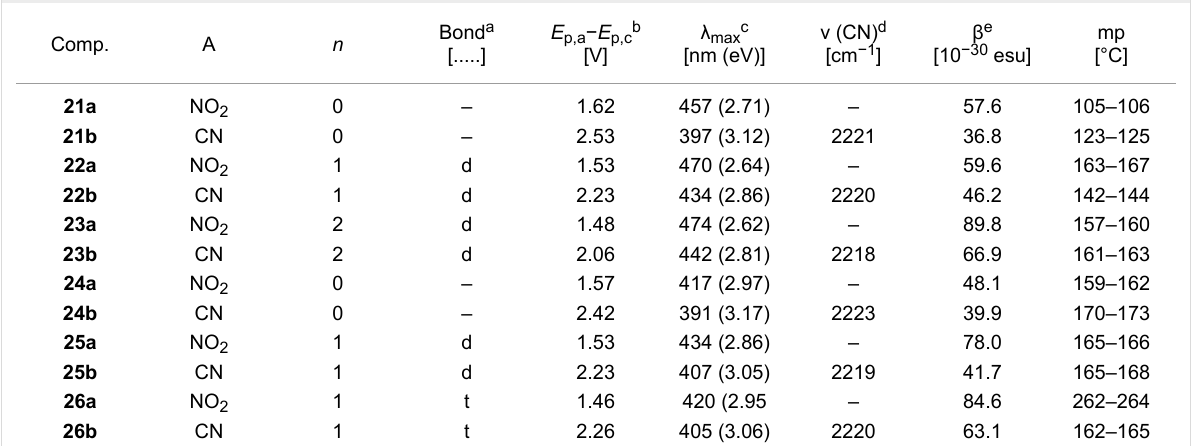
Table 5: Properties of chromophores 21 – 26 [12].